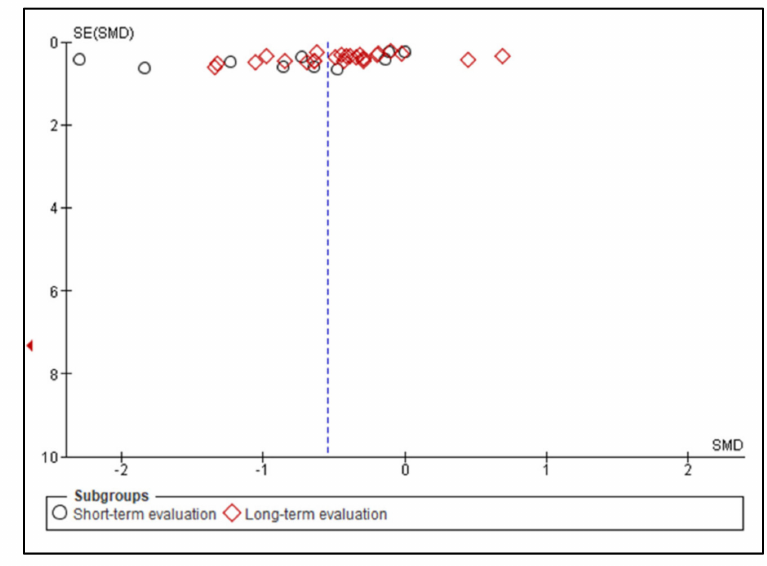
Figure 10. Funnel plot summary for primary outcome qualitative pain reduction assessment (PPT) from baseline up to the final follow-up timepoint.